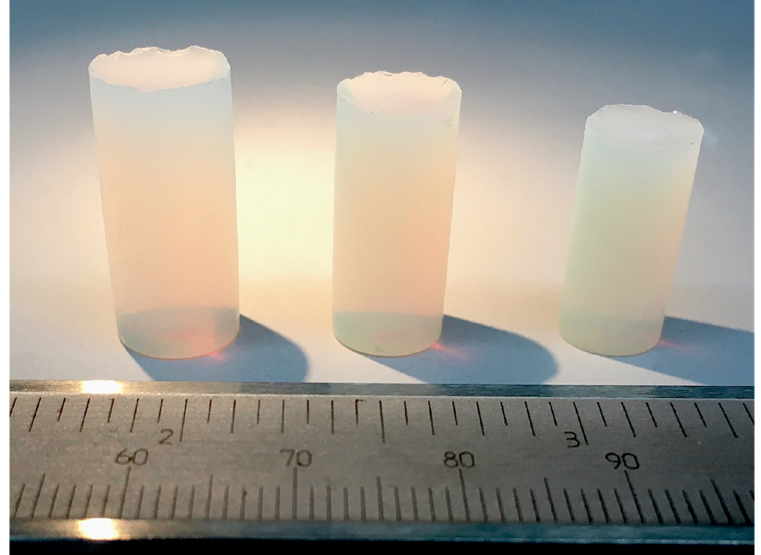
Figure 1. Representative sample set of SiO 2 –GPTMS–gelatin hybrid aerogels extracted from a supercritical drying CO 2 autoclave. The aerogels were aligned by increasing gelatin content from left to right: 15 wt. %, 25 wt. %, and 30 wt. %.